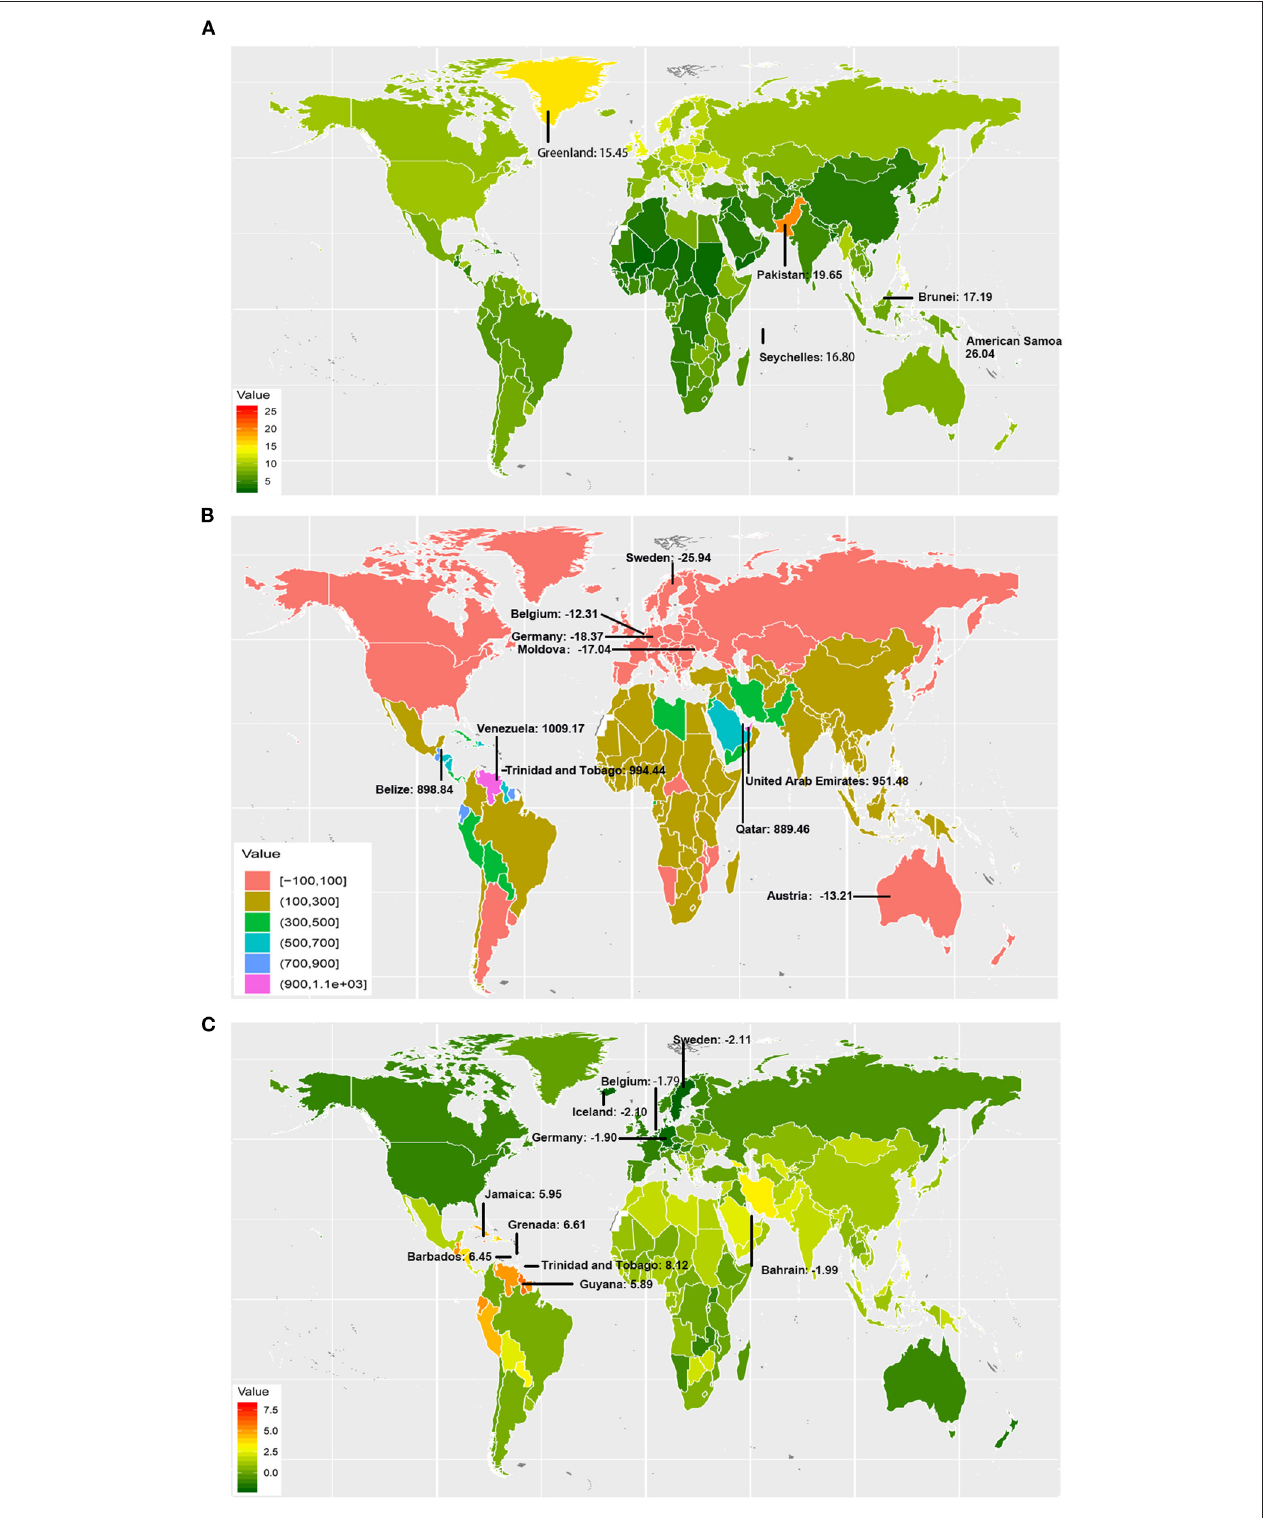
FIGURE 1 | The incidence burden of ovarian cancer in 195 countries and territories. (A) The ASIR (per 100,000 people) of ovarian cancer globally in 2017; American Samoa, Pakistan, Brunei, Seychelles, and Greenland had the top 5 ASIR in 2017. (B) The relative change (%) in incident cases of ovarian cancer between 1990 and 2017; the greatest changes were exhibited in Venezuela and Sweden. (C) The EAPC of ovarian cancer ASIR from 1990 to 2017; the greatest EAPC were exhibited in Trinidad and Tobago, and Sweden. ASIR, age-standardized incidence rate; EAPC, estimated annual percentage change.